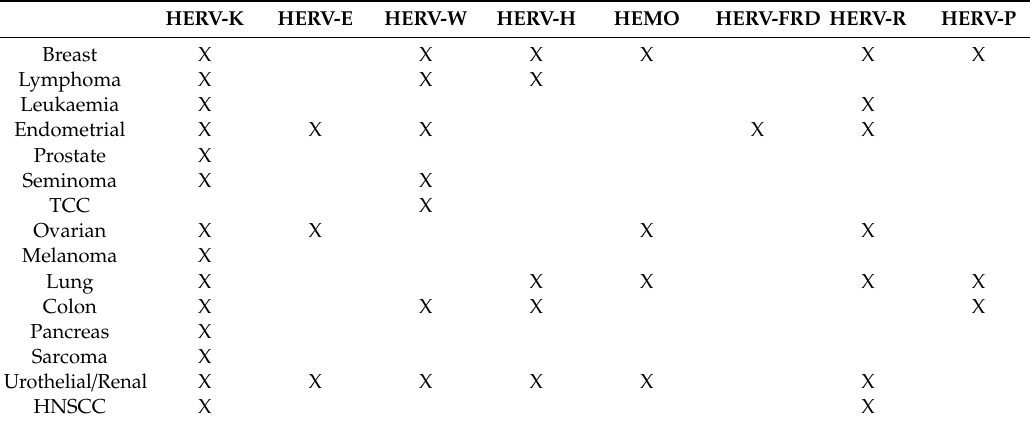
Table 1. Overview table of the HERVs detected in several cancers 1